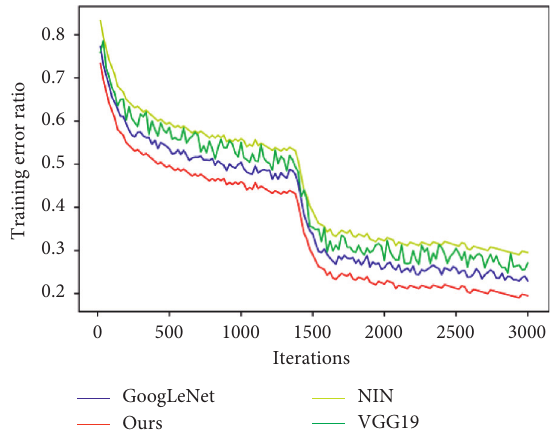
Figure 7: Training error